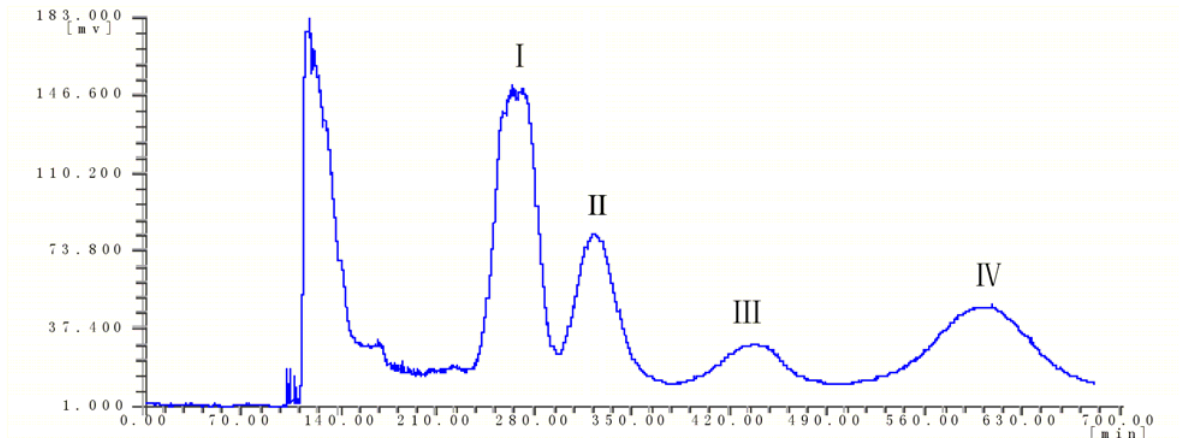
Figure 3. Chromatogram of HSCCC for separation of C. deserticola